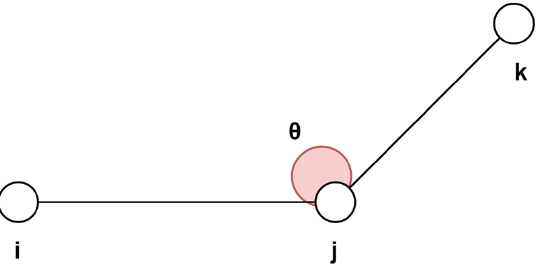
Figure 2. Example of an angle θ formed from 3 consecutive nodes i, j and k.